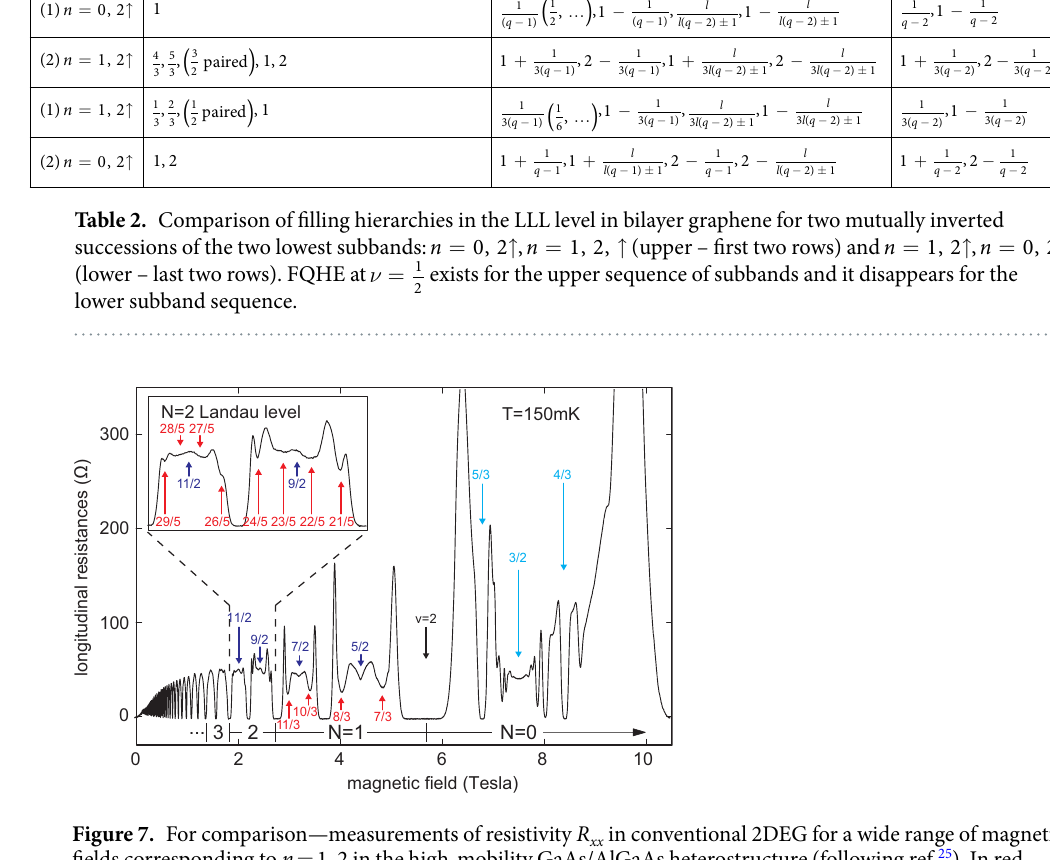
Figure 7. For comparison—measurements of resistivity R xx in conventional 2DEG for a wide range of magnetic fields corresponding to n = 1, 2 in the high-mobility GaAs/AlGaAs heterostructure (following ref. 25 ). In red colour, fractions are indicated for the FQHE (single-loop)—doublets with denominator 3 in subbands with n = 1 and quartets with denominator 5 for n = 2, in accordance with braid commensurability predictions. The pair with denominator 3 for n = 0 (blue, 5/3, 4/3) corresponds to 3-loop orbits. At 11/2, 9/2, 7/2, and 5/2, the braid group approach predicts paired states, but for 3/2 and 1/2, it predicts Hall metal. A similar structure of FQHE is predicted for monolayer graphene, though the data for n = 2 in monolayer graphene are not available